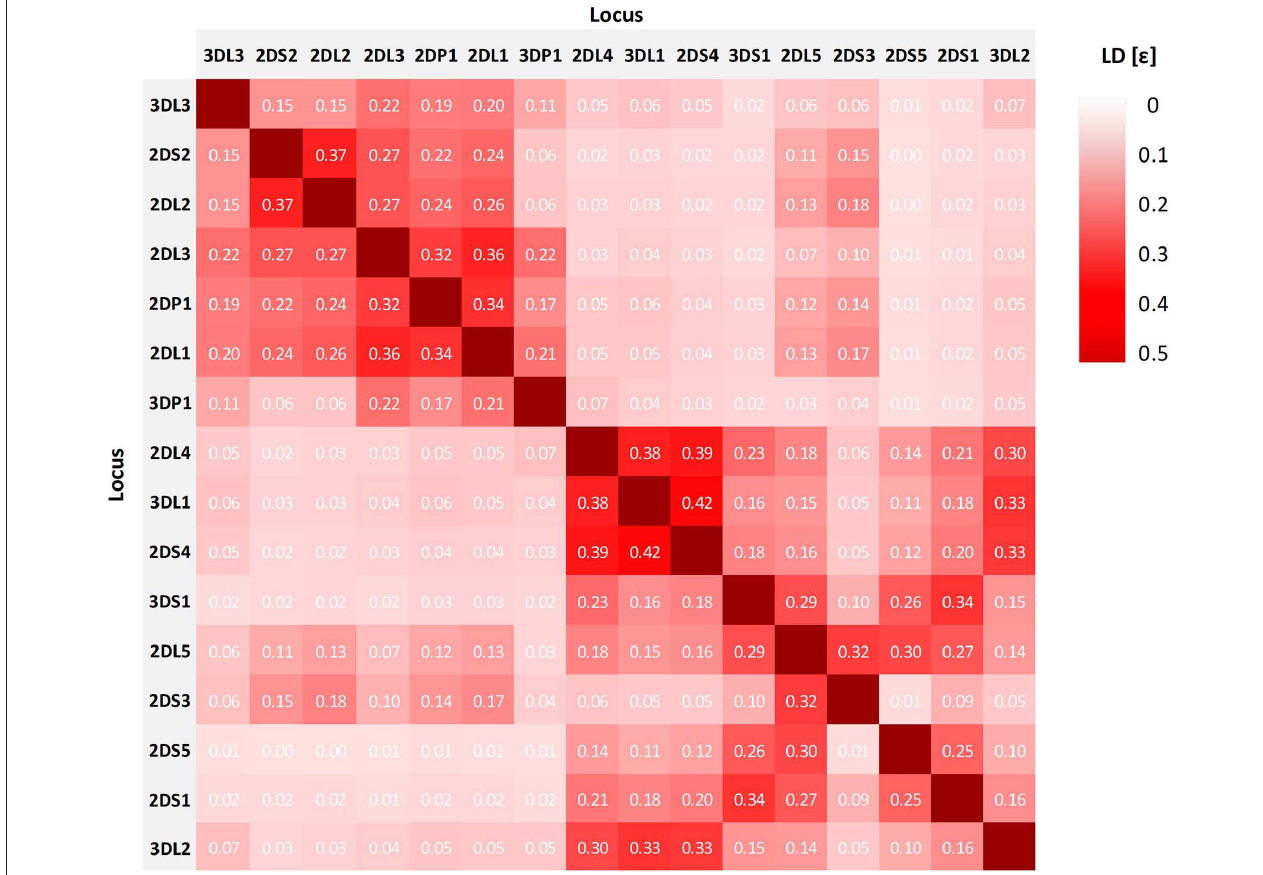
FIGURE 4 | Overall linkage disequilibrium of 16 KIR loci in genomic orientation as designated by the normalized entropy difference ε . The value of ε ranges between 0 and 1, with larger values indicating stronger LD. Values of ε are displayed in the